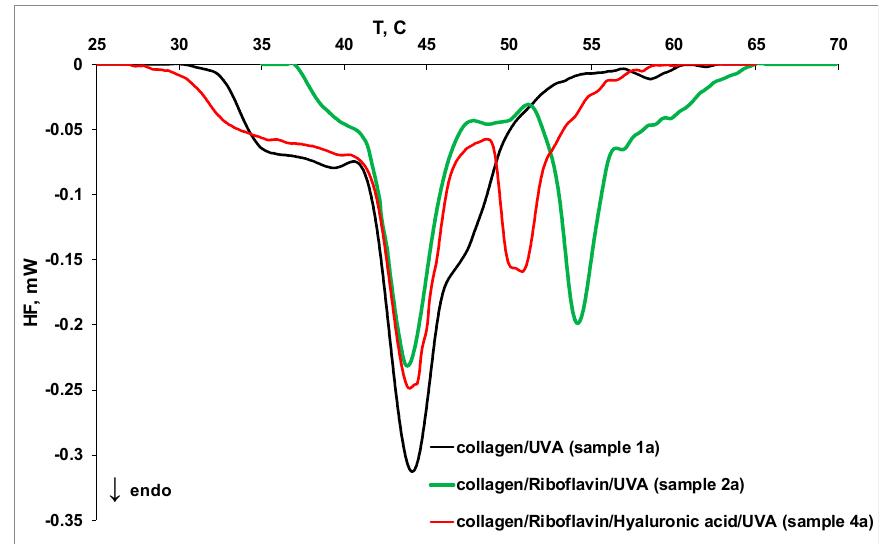
Figure 7. The DSC thermograms for thermal denaturation of collagen (sample 1a ), collagen/riboflavin (sample 2a ), and collagen/riboflavin/hyaluronic acid (sample 4a ) under UVA irradiation at pH 7.5. Table 4. Peak temperatures and denaturation heat of collagen in different systems at pH 7.5. T peak1 , Sample ◦